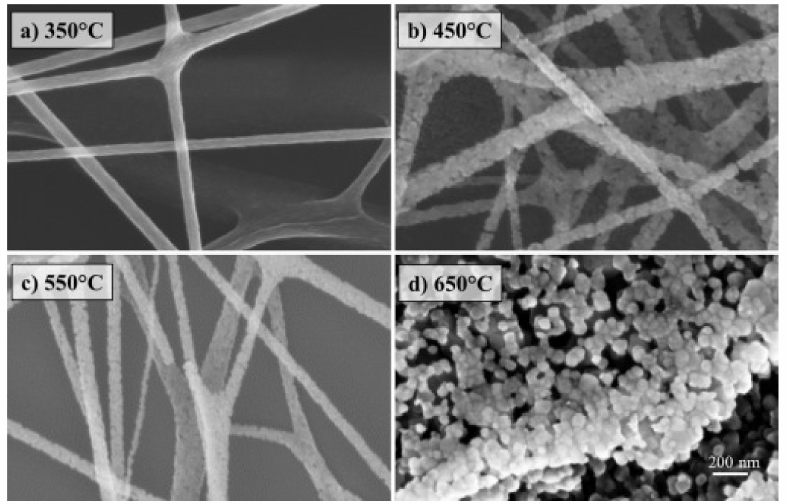
Figure 6. Scanning Electron Microscopy (SEM) images of ZnO nanofibers with diverse morphology produced at different temperatures ( a ) 350 ◦ C, ( b ) 450 ◦ C, ( c ) 550 ◦ C, and ( d ) 650 ◦ C. Reprinted from [83] with permission from